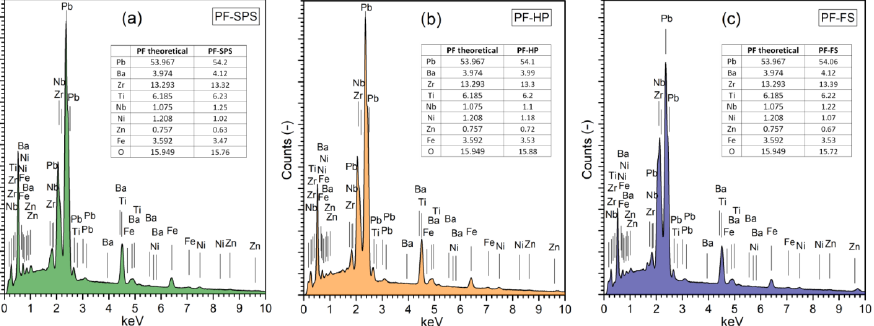
Figure 6. The EDS surface analysis for the PF composite samples: PF-SPS ( a ), PF-HP ( b ), and PF-FS ( c ). The density of multiferroic composite samples determined by the Archimedes method is 6.26 × 10 3 kg/m 3 for PP-SPS, 7.12 × 10 3 kg/m 3 for PF-HP, and 6.72 × 10 3 kg/m 3 for PF-FS.